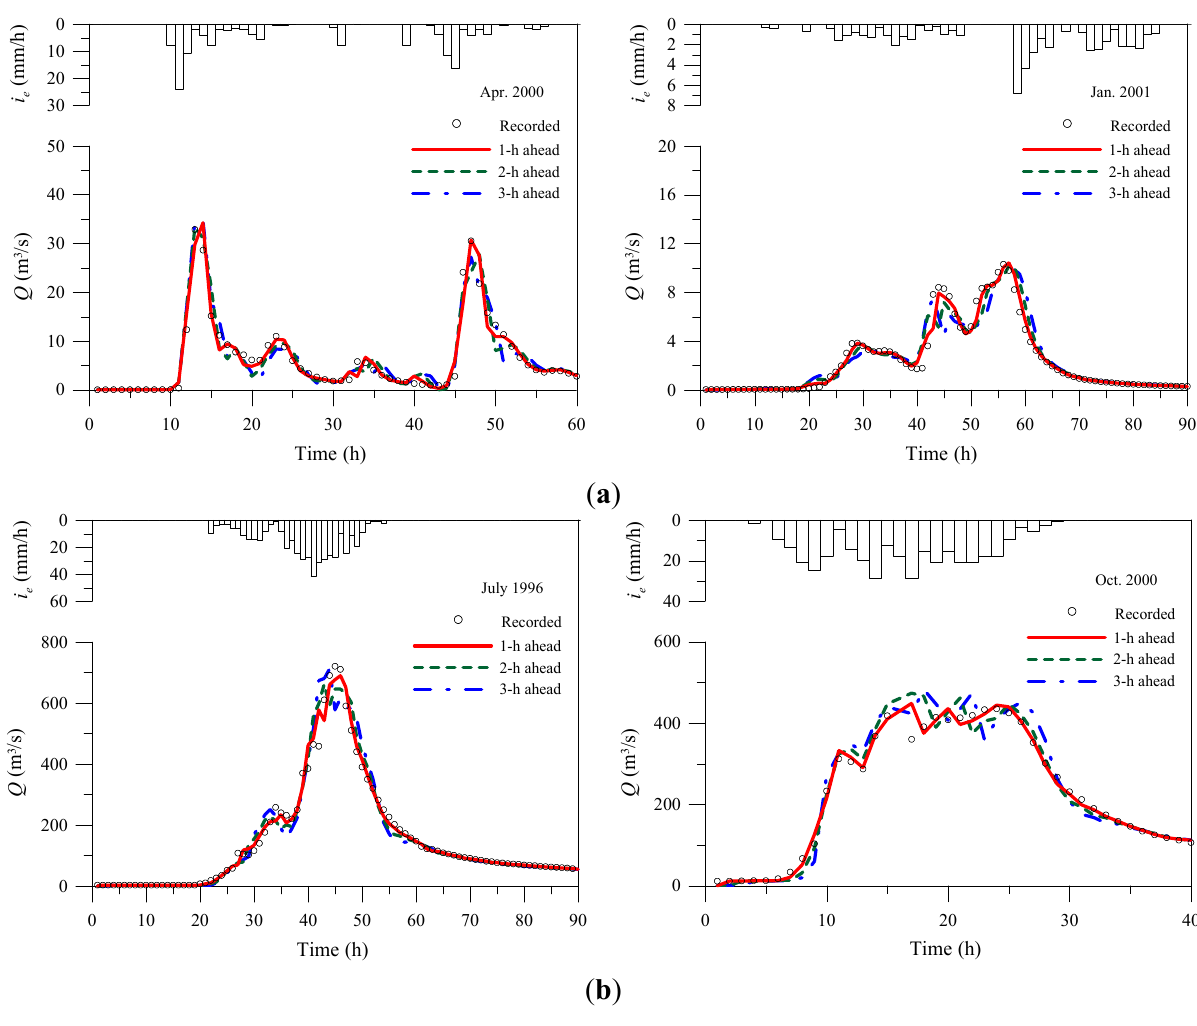
Figure 9. Flow forecasting using measured rainfall and flow updating algorithm in Goodwin Creek and San-Hsia watersheds: ( a ) Goodwin Creek watershed (STA 01); ( b ) San-Hsia